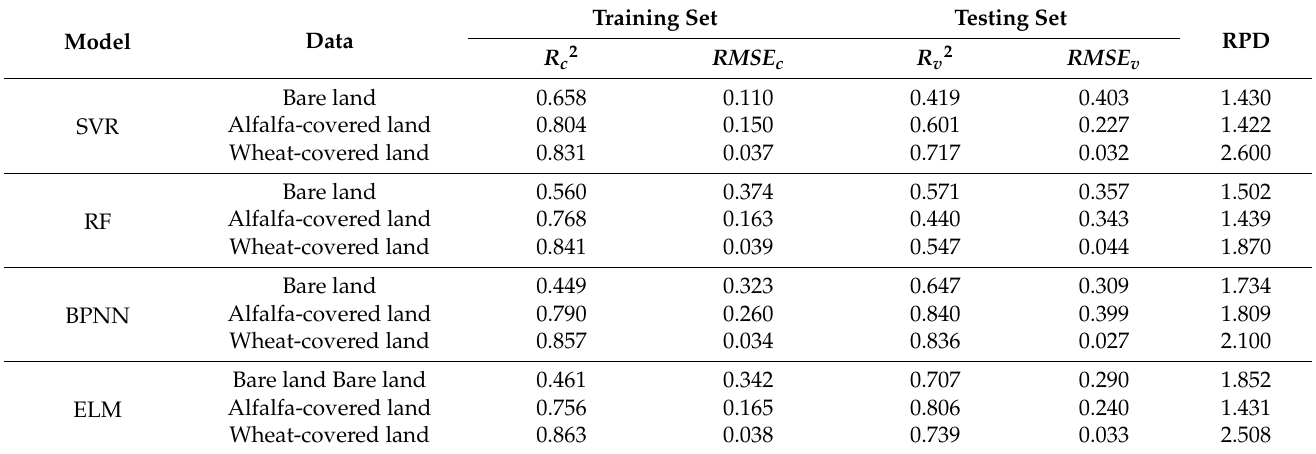
Table 7. The results of the soil salt content inversion model based on the spectral